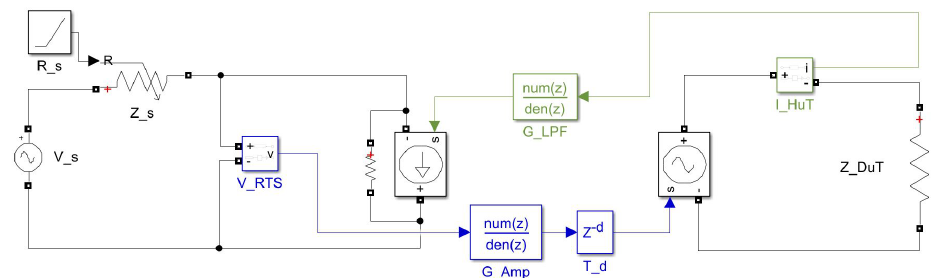
Figure 14. MATLAB Simulink™ model for validation of the stability